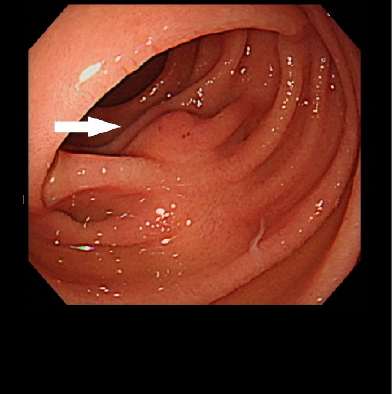
Figure 2. Endoscopic view of the lesion (arrow).